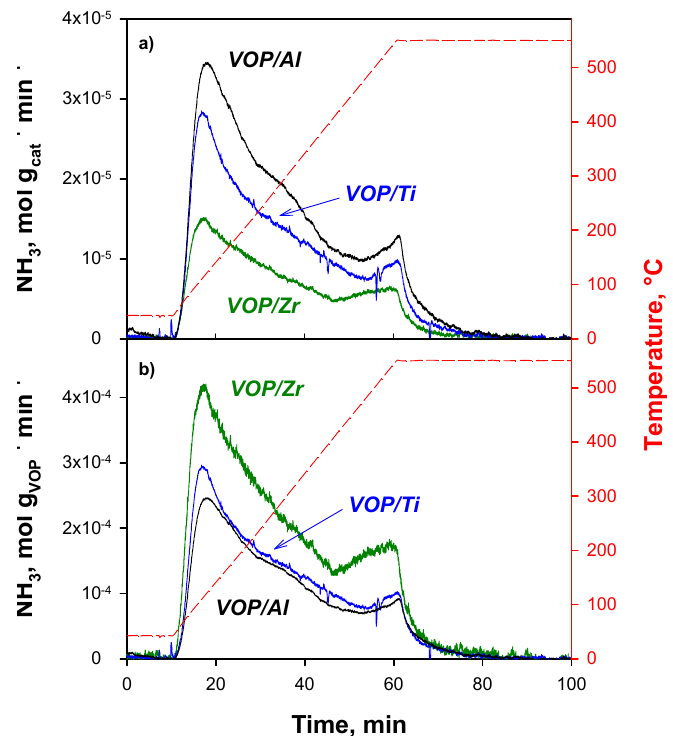
Figure 3. NH 3 -TPD profiles of the VOP/x catalysts for the catalyst ( a ) and VOP weight ( b ).